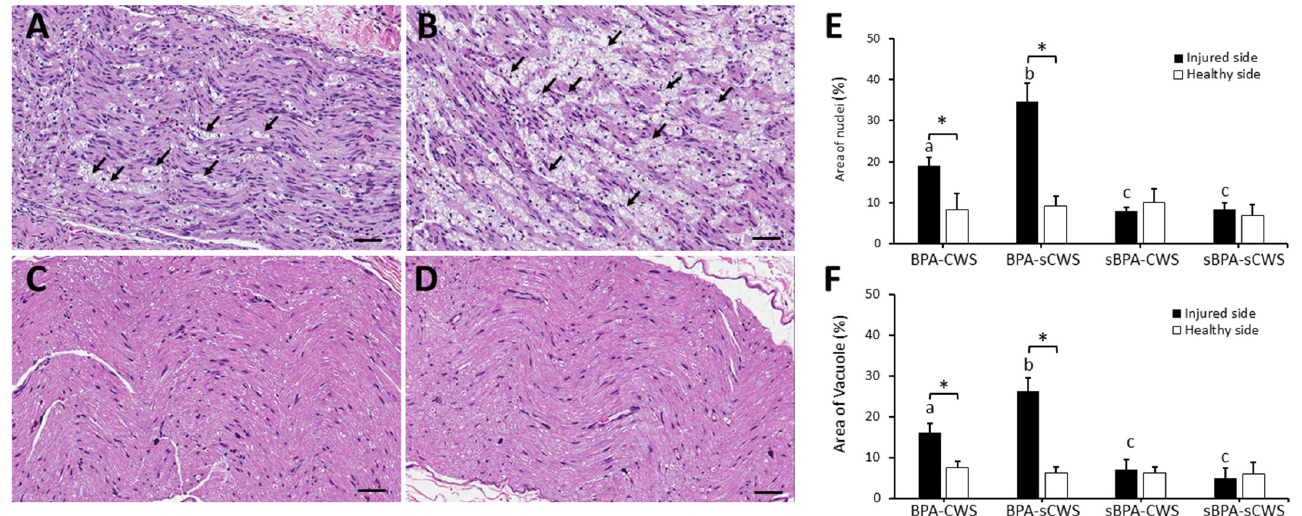
Figure 2. H&E staining in longitudinal cuts of transected nerves of representative animals. The arrows indicate myelin-digestion chambers (vacuole formation). Enhanced vacuole formation and loss of myelinated fibers were found in representative animals treated with BPA–CSW ( A ) and BPA–sCWS ( B ) while intact myelinated fibers were found in representative animals treated with sBPA–CWS ( C ) and sBPA–sCWS ( D ). Data of area of inflammatory cells ( E ) and vacuole formation ( F ) in percentage are presented as mean ± SD. Values with different superscripts (e.g., a vs. b and b